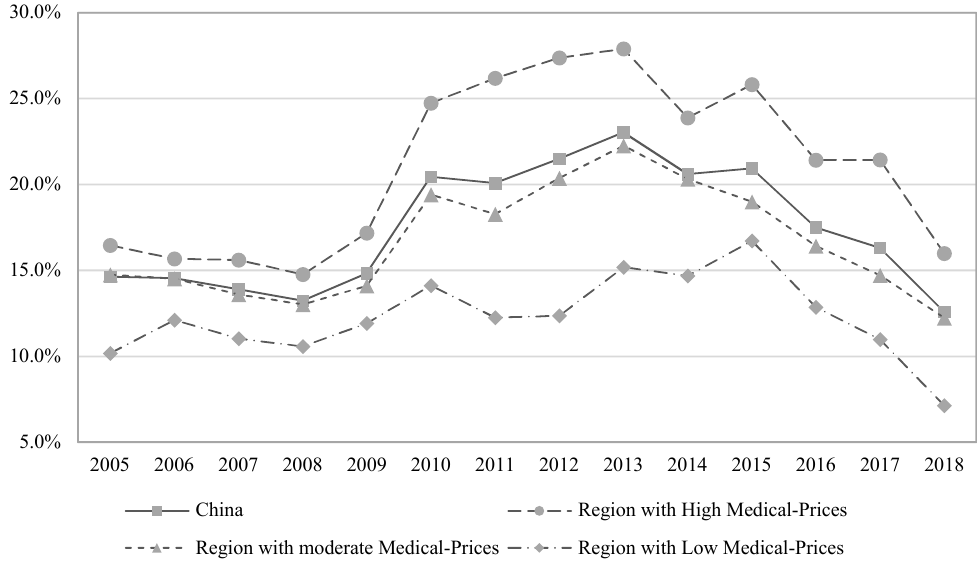
Figure 1. The unmet demand for China and the regions.